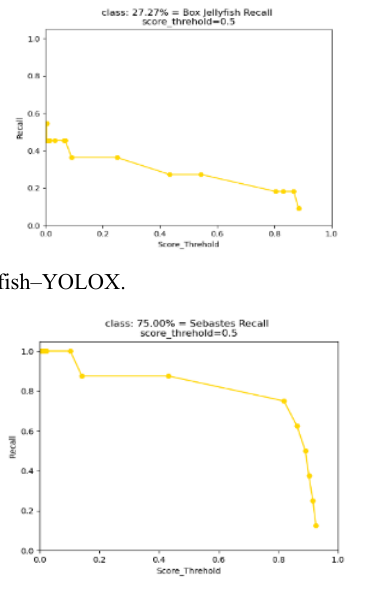
Fig. 6. The recall rate of sebastes-YOLOX.